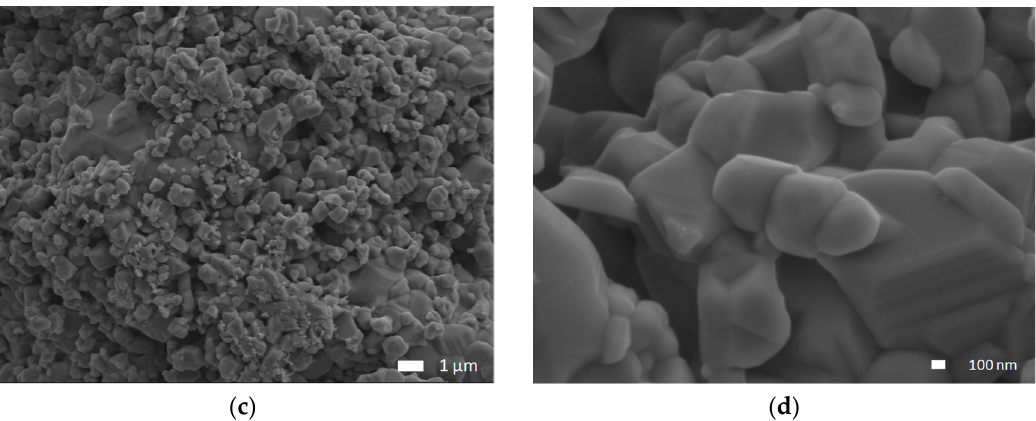
Figure 1. ( a ) X-ray diffraction pattern, ( b ) high-resolution X-ray photoelectron spectroscopy (XPS) spectra showing the Ti2p core levels, and ( c , d ) SEM images at different magnifications of LTO sample. Table 1. Average crystallite size, unit cell parameters and quantitative analysis by peak-profile fitting for lithium titanate or Li 4 Ti 5 O 12 (LTO) electrodes before and after magnesiation. Li 4 Ti 5 O